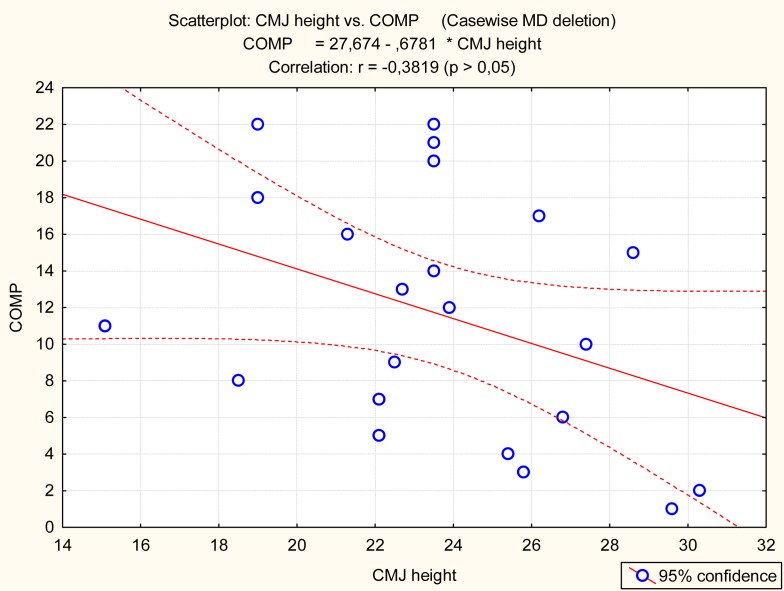
Graphical presentation of the relationship between CMJ (CMJ height) and competitive achievement (COMP)